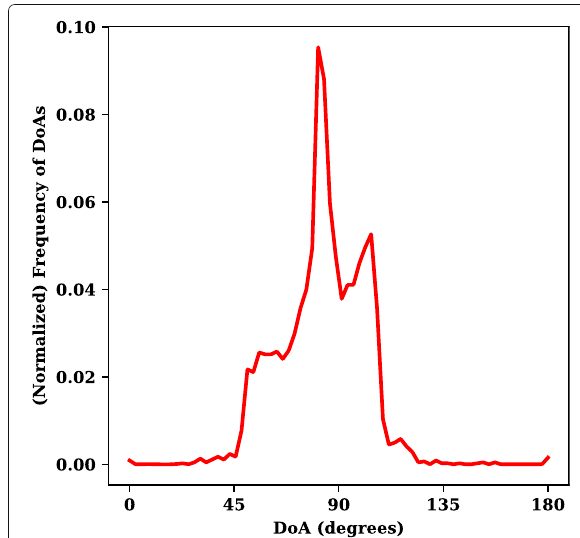
Fig. 3 Histogram of SRP-NMF on a mixture of 3 sources taken from the SiSEC database dev1_male3_liverec_250ms_5cm_mix. wav , with β = 0 and D T = 35. The ground truth DoAs are 50 ◦ ,80 ◦ and 105 ◦ . The estimate does not clearly present evidence for the 1 st peak at 50